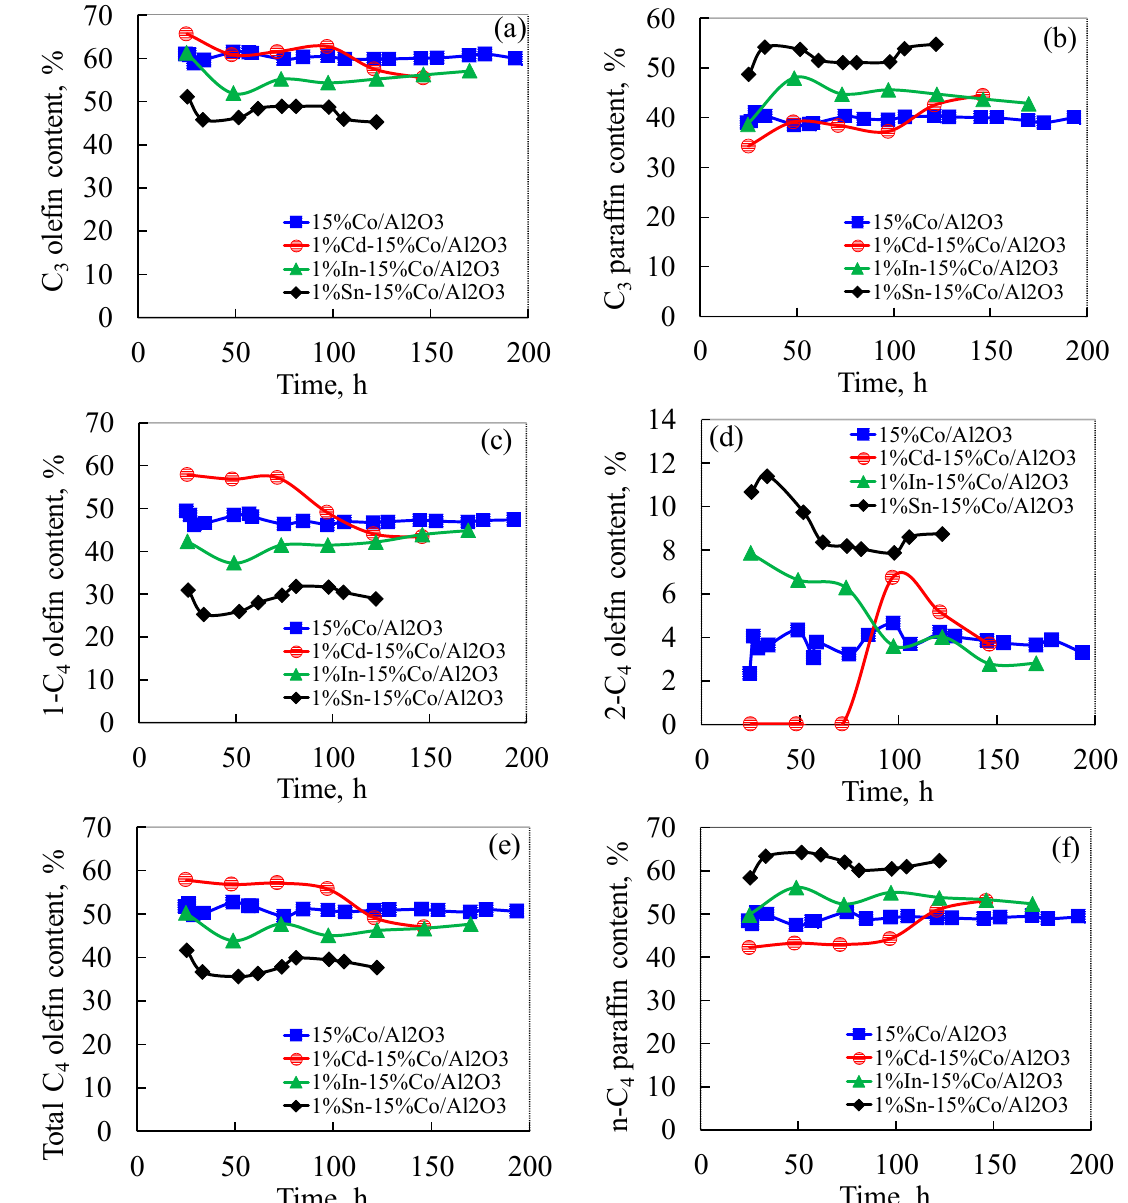
Figure 6. Change of ( a ) C 3 olefin selectivity, ( b ) C 3 paraffin selectivity, ( c ) 1-C 4 olefin selectivity, ( d ) 2-C 4 olefin selectivity, ( e ) total-C 4 olefin selectivity and ( f ) C 4 paraffin selectivity with time over npromoted and Cd, In and Sn promoted 15%Co/Al 2 O 3 catalysts. Reaction conditions: 220 °C, 2.2 MPa, H 2 /CO = 2.1, X CO = 40–50%.